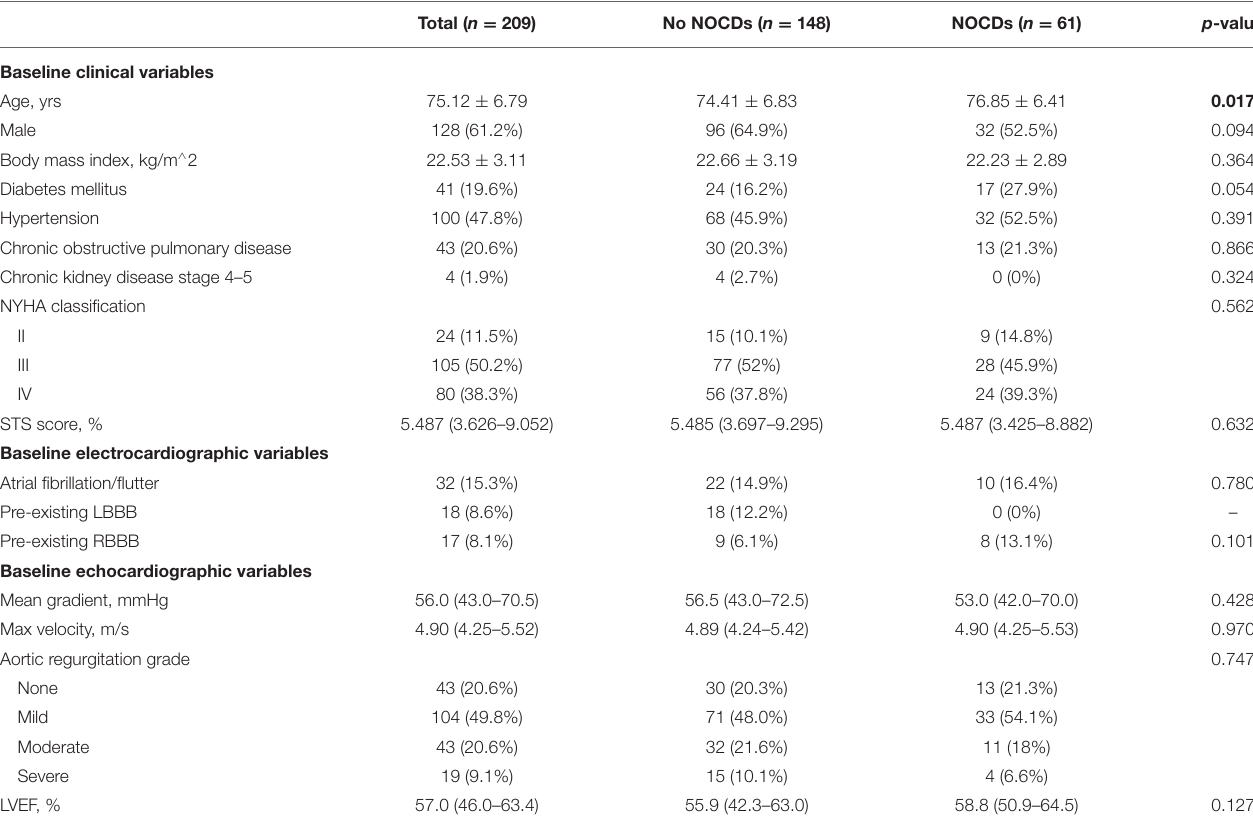
TABLE 1 | Baseline clinical characteristics of bicuspid aortic stenosis patients and